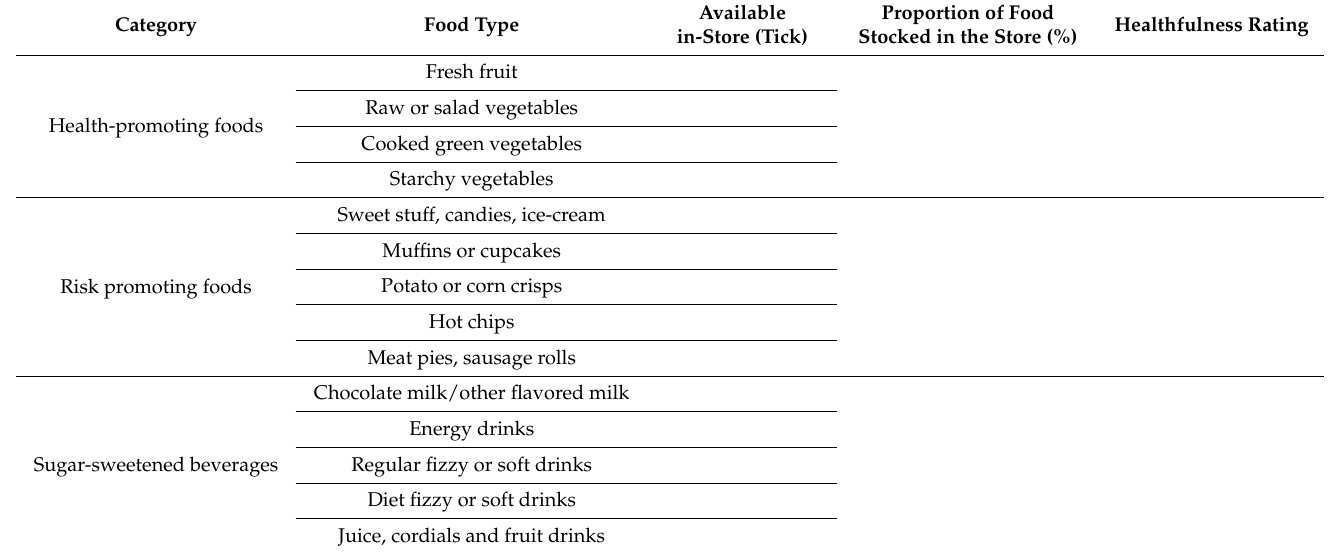
Table 1. Rubric used to assess the quality of food available in each outlet.